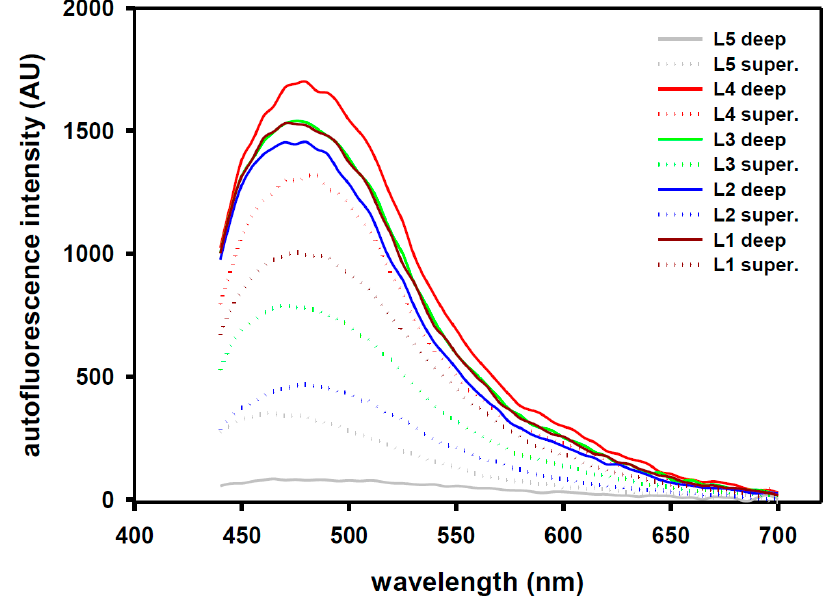
Figure 5. Examined by multimode microplate reader (Infinite 200 Pro, Tecan Group Ltd., Switzerland) to the deep and superficial LF samples that from L1 to L5, 405-nm light was selected as excitation wavelength. The deep component showed higher fluorescence intensity than the superficial one except for the L5.